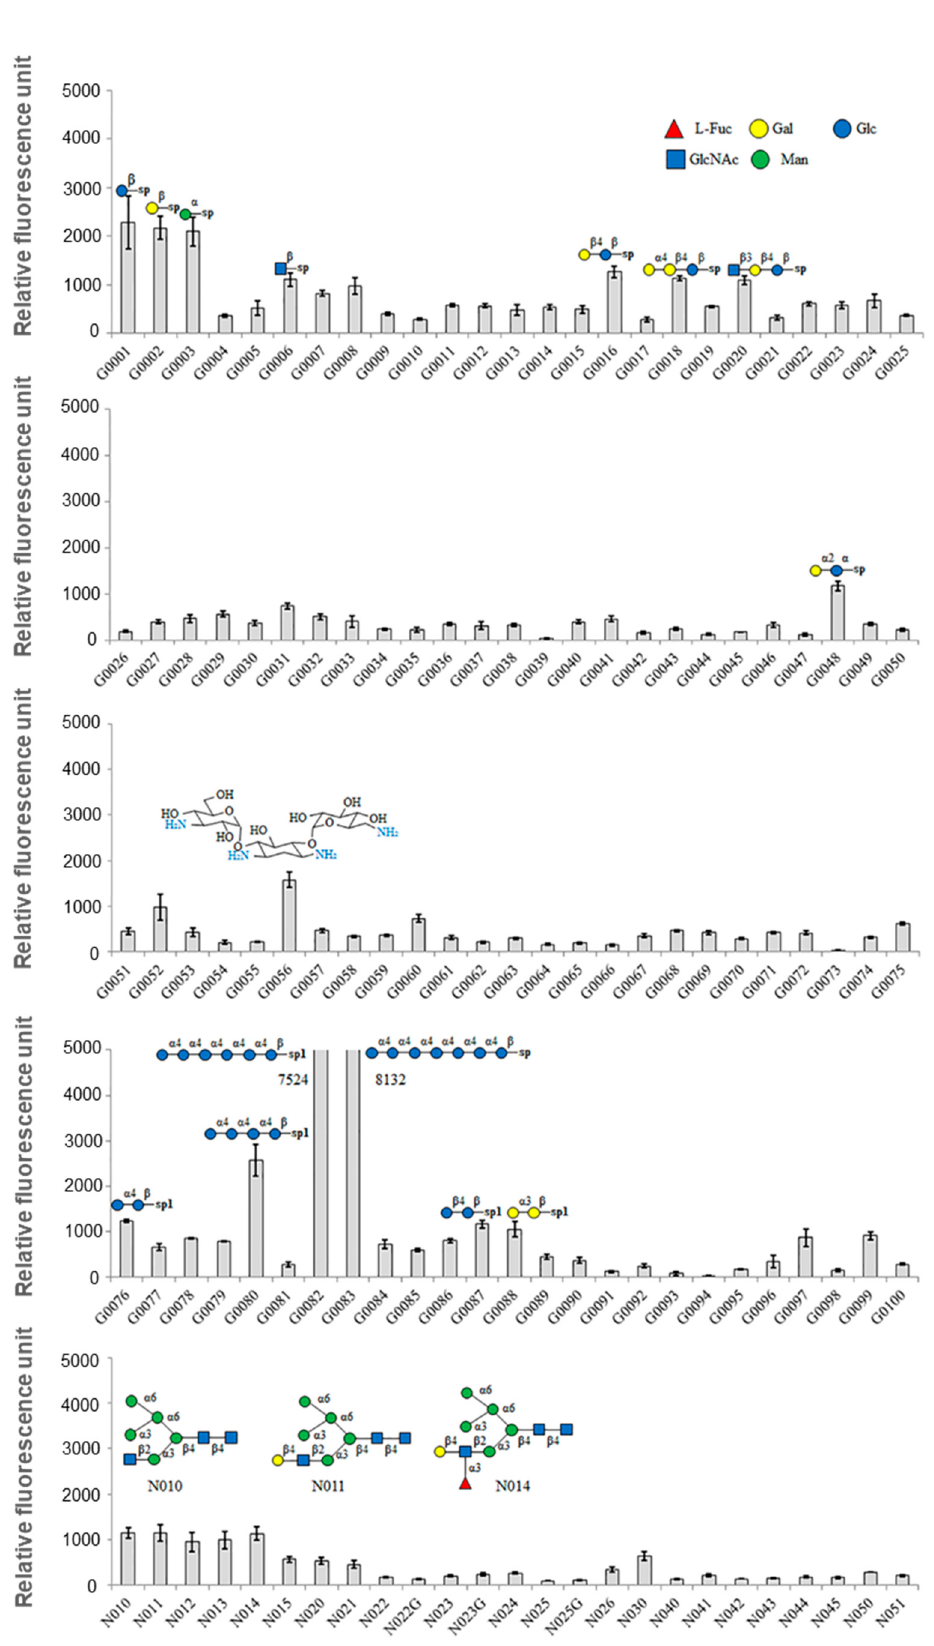
Figure 4. Glycan array of Grateloupia chianggi lectin. Relative fluorescence units were calculated using an array analysis program (RayBioTech). The glycan structure is given for signals that exceeded 1000 relative fluorescence units. Error bars represent mean ± standard deviation (SD) of triplicate experiments.